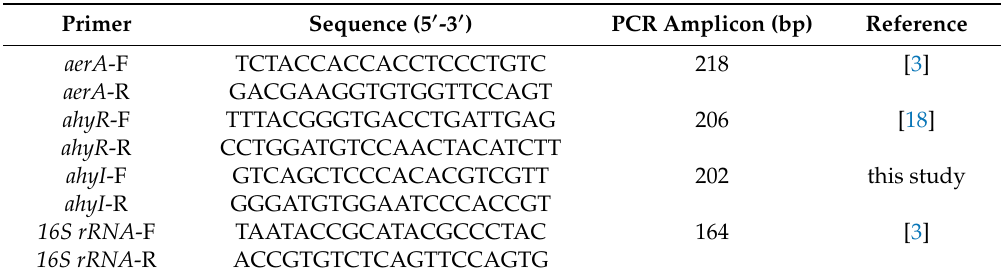
Table 1. Primer pairs used for